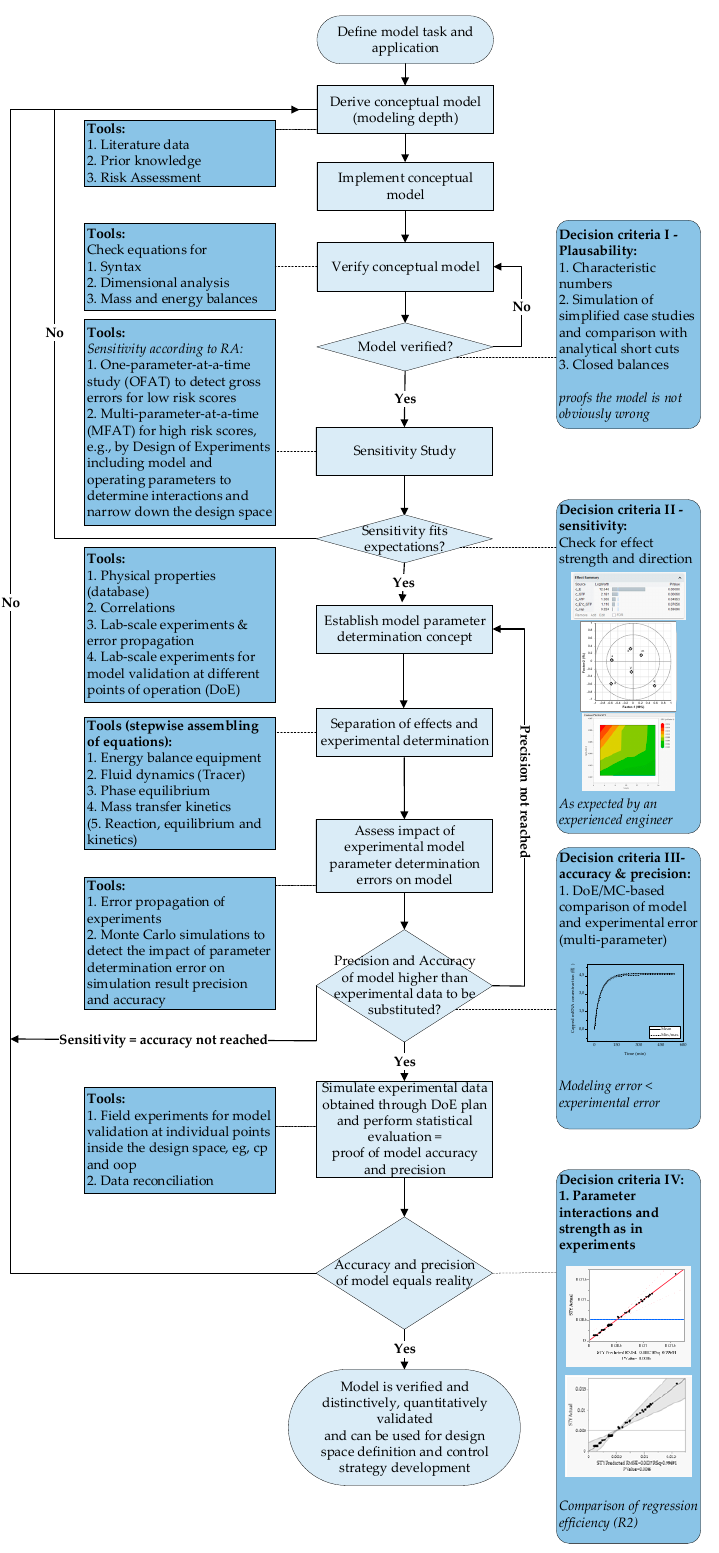
Figure 3. Decision tree for a process model validation according to Sixt et al. The application allows a quantitative evaluation of the model quality based on mechanistic and statistical decision criteria. A rigorous execution of the procedure leads to a distinctively and quantitatively validated rigorous process